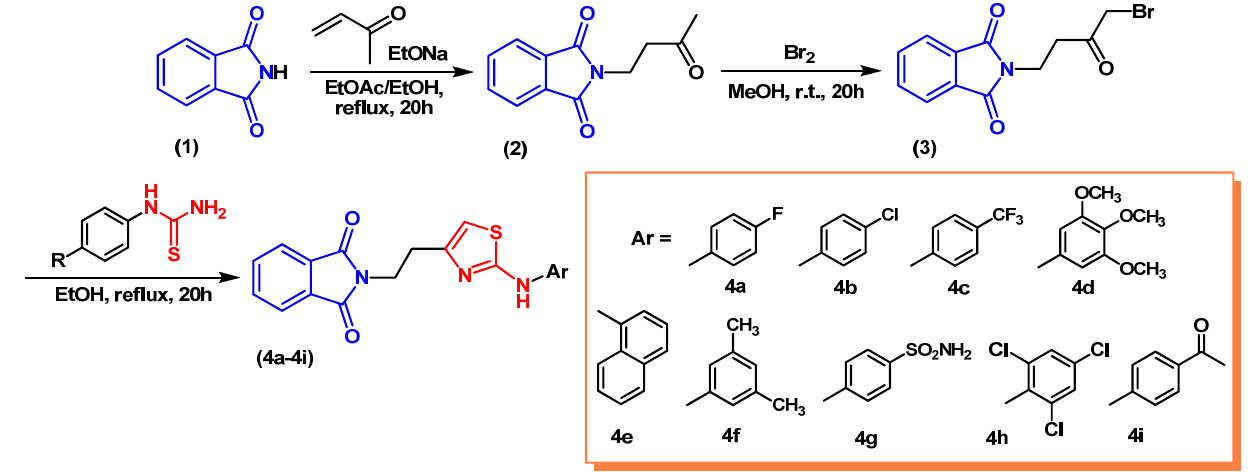
Table 1. Elastase inhibitory activity of phthalimide-thiazoles 4a – 4i compared to standard